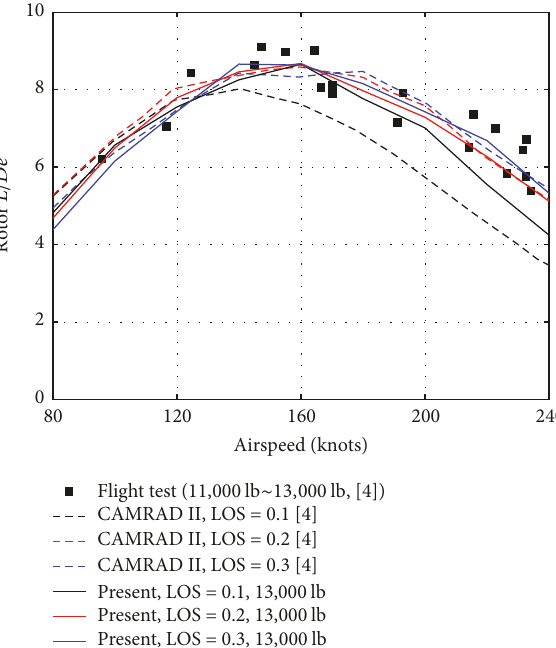
Figure 12: Validation of the rotor effective lift-to-drag ratio in compound helicopter